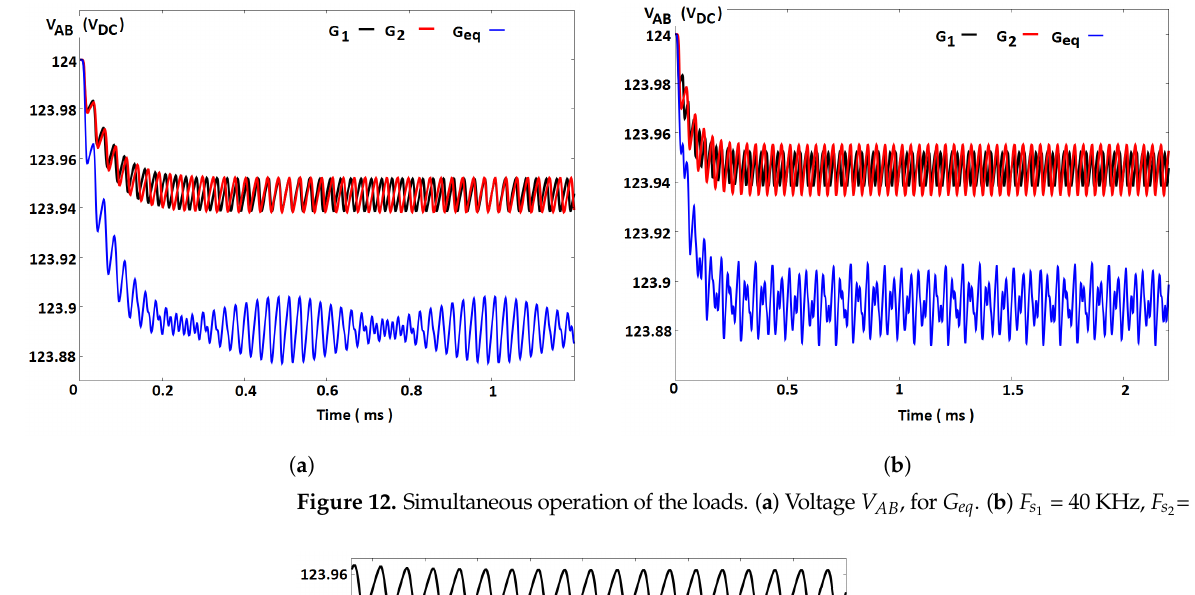
Figure 12. Simultaneous operation of the loads. ( a ) Voltage V AB , for G eq . ( b ) F s